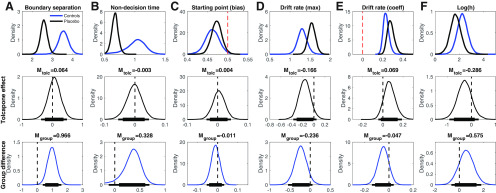
Top row, Group-level posterior distributions for parameter means in the gamblers under placebo (n = 14, solid black line) and the Peters and D'Esposito (2020) controls (n = 19, solid blue line). A, Boundary separation. B, Non-decision time. C, Bias. D, vmax. E, vcoeff. F, log(h) [risk-taking]. The dashed red line in C denotes 0.5, i.e., a neutral bias. The dashed red line in E denotes zero, i.e., no value modulation of the drift rate. Center row, Group level posterior distributions for tolcapone-induced changes for each parameter. Bottom row, Posterior distributions of group differences between gamblers under placebo from the present study and the control group from Peters and D'Esposito (2020). The thin (thick) horizontal lines in the center and bottom row indicate 95% (85%) highest density intervals.